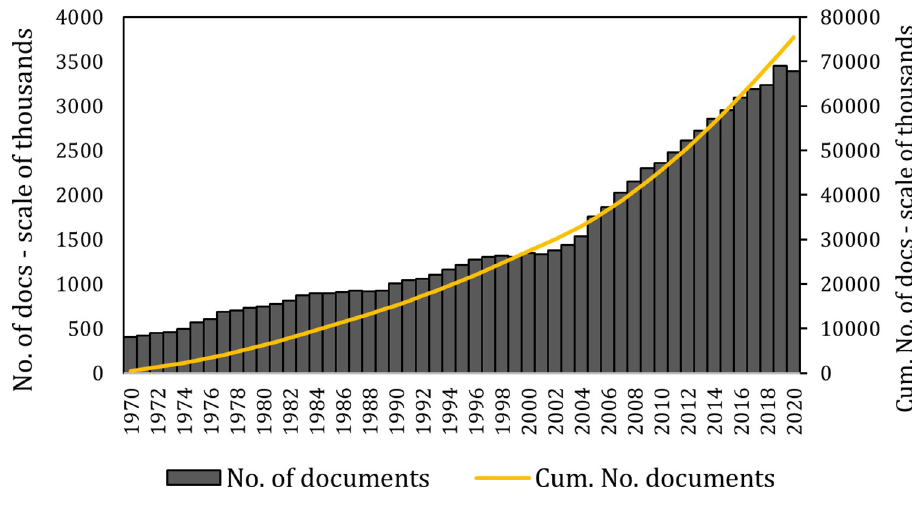
Fig 1. Cumulative growth of science during